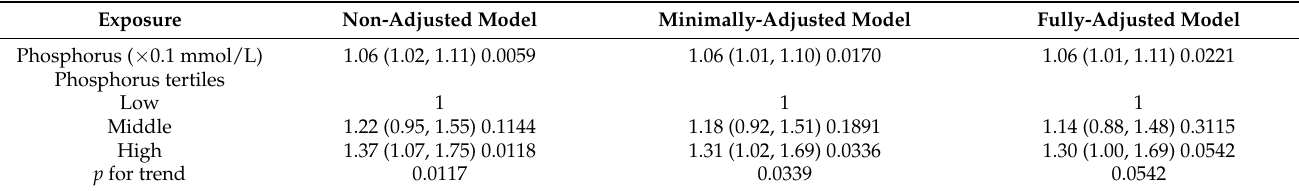
Table 3. Univariate and multivariate results by linear regression.